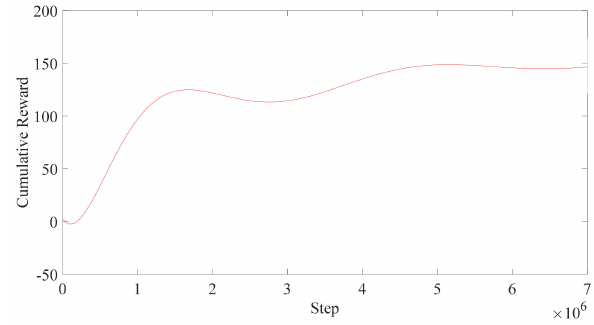
Figure 17. The training result of